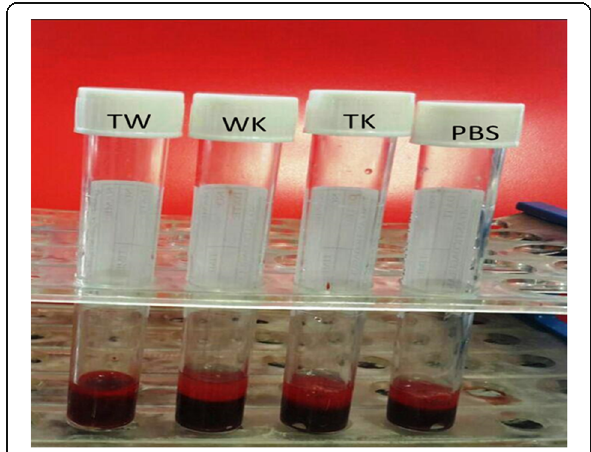
Fig. 5 The cytotoxicity test of two killer toxins. TW tap water (positive control), TK Torulaspora delbrueckii killer toxin, WK Wickerhamomyces anomalus killer toxin, PBS phosphate-buffered saline (negative